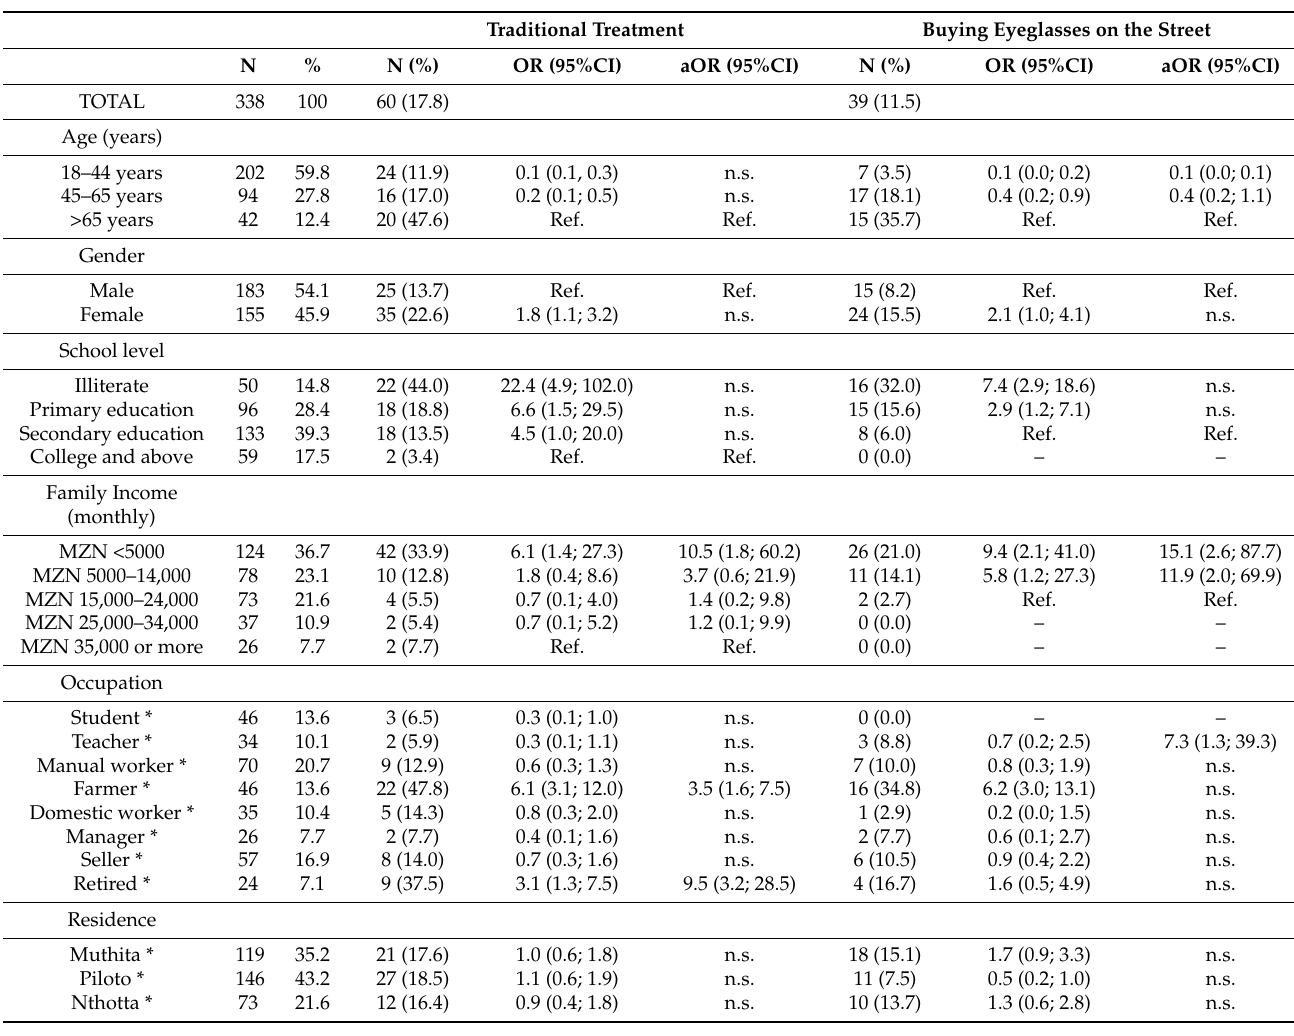
Table 3. Barriers to accessing eye health services and associated factors